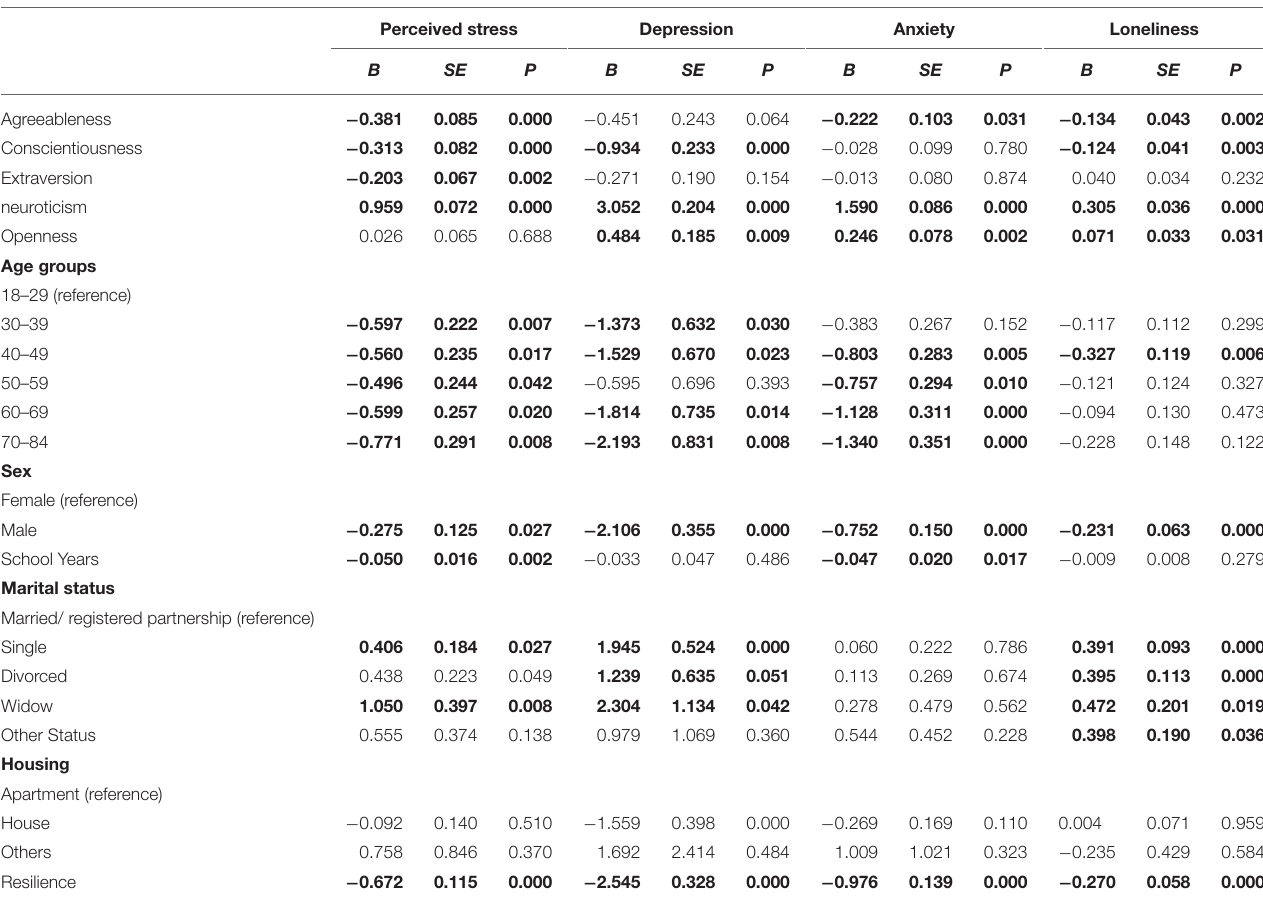
TABLE 4 | Associations of mental health outcomes, personality traits, and resilience, controlling for sociodemographic variables. Perceived stress Depression Anxiety Loneliness